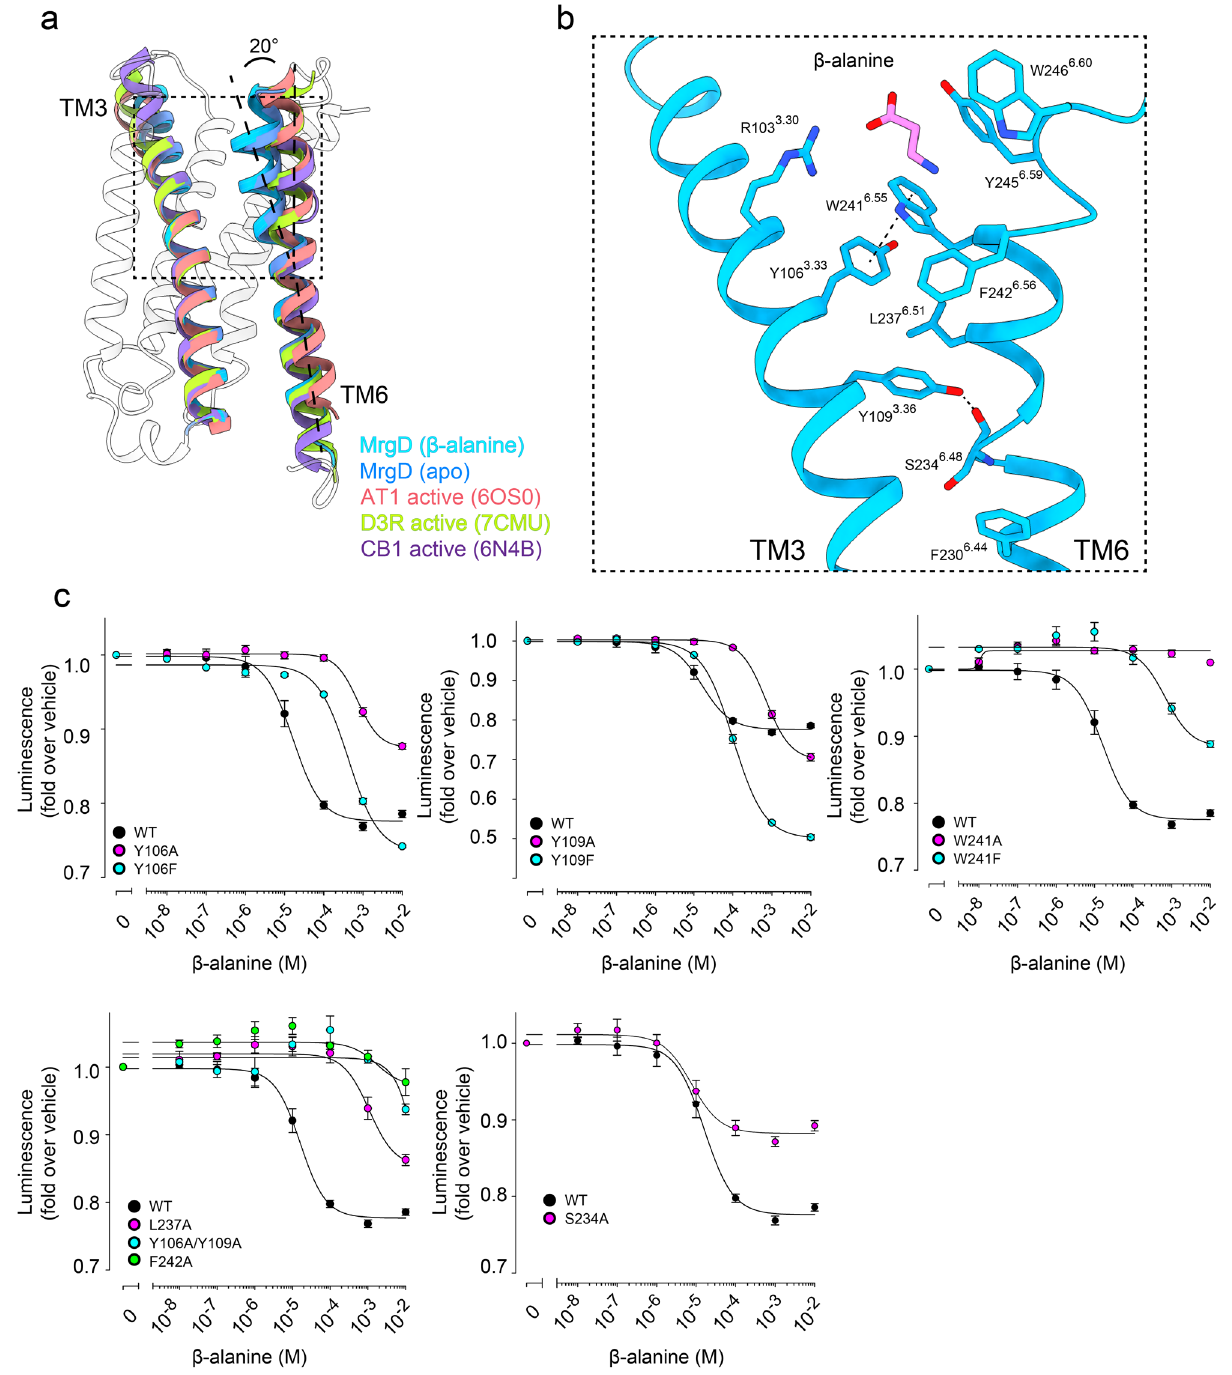
Fig. 4 Unconventional activation of MrgD. a Superposition of TM3 and TM6 of β -alanine-bound MrgD (cyan), apo-MrgD (blue), active AT1R 35 (salmon, PDB code: 6Os0), active D3R 37 (green, PDB code: 7CMU), and active CB1R 38 (purple, PDB code: 6N4B). For MrgD, the extracellular half of TM6 is tilted about 20° toward the TM3. b Magni fi ed view of the area around the toggle switch on MrgD. The residues and ligands are shown as sticks. c NanoBiT – G- protein dissociation assay of the MrgD mutants for the residues in the extracellular half between TM3 and TM6. Dose-response curves are shown as means ± s.e.m. of six independent experiments for WT and three for the mutants. Data for the graphs in c are available as Supplementary Data